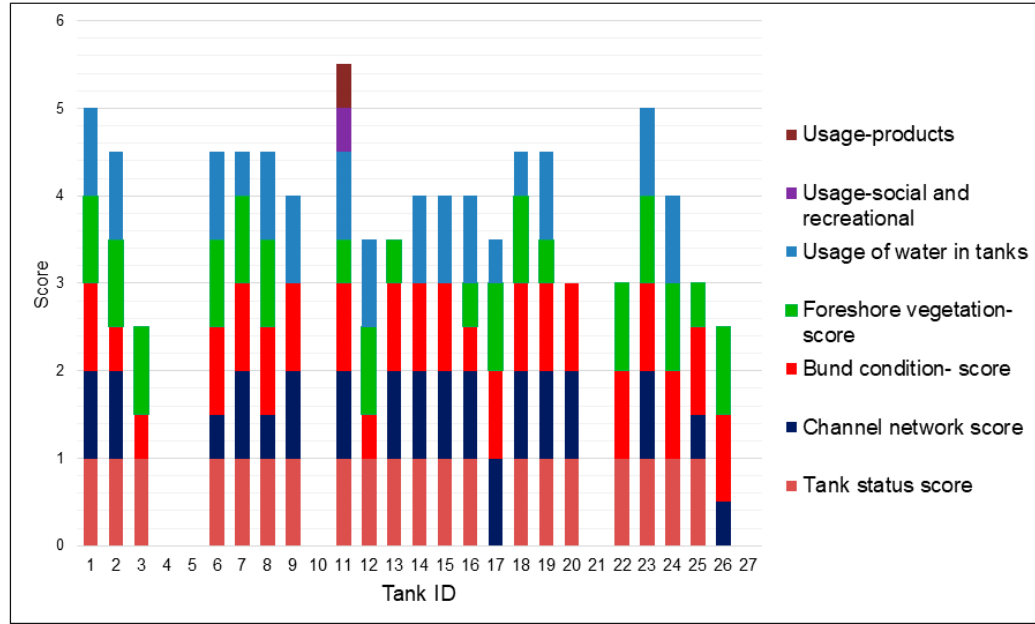
Figure 11. Case 1: Score of tanks based on components. Water 2019 , 11 , x FOR PEER REVIEW